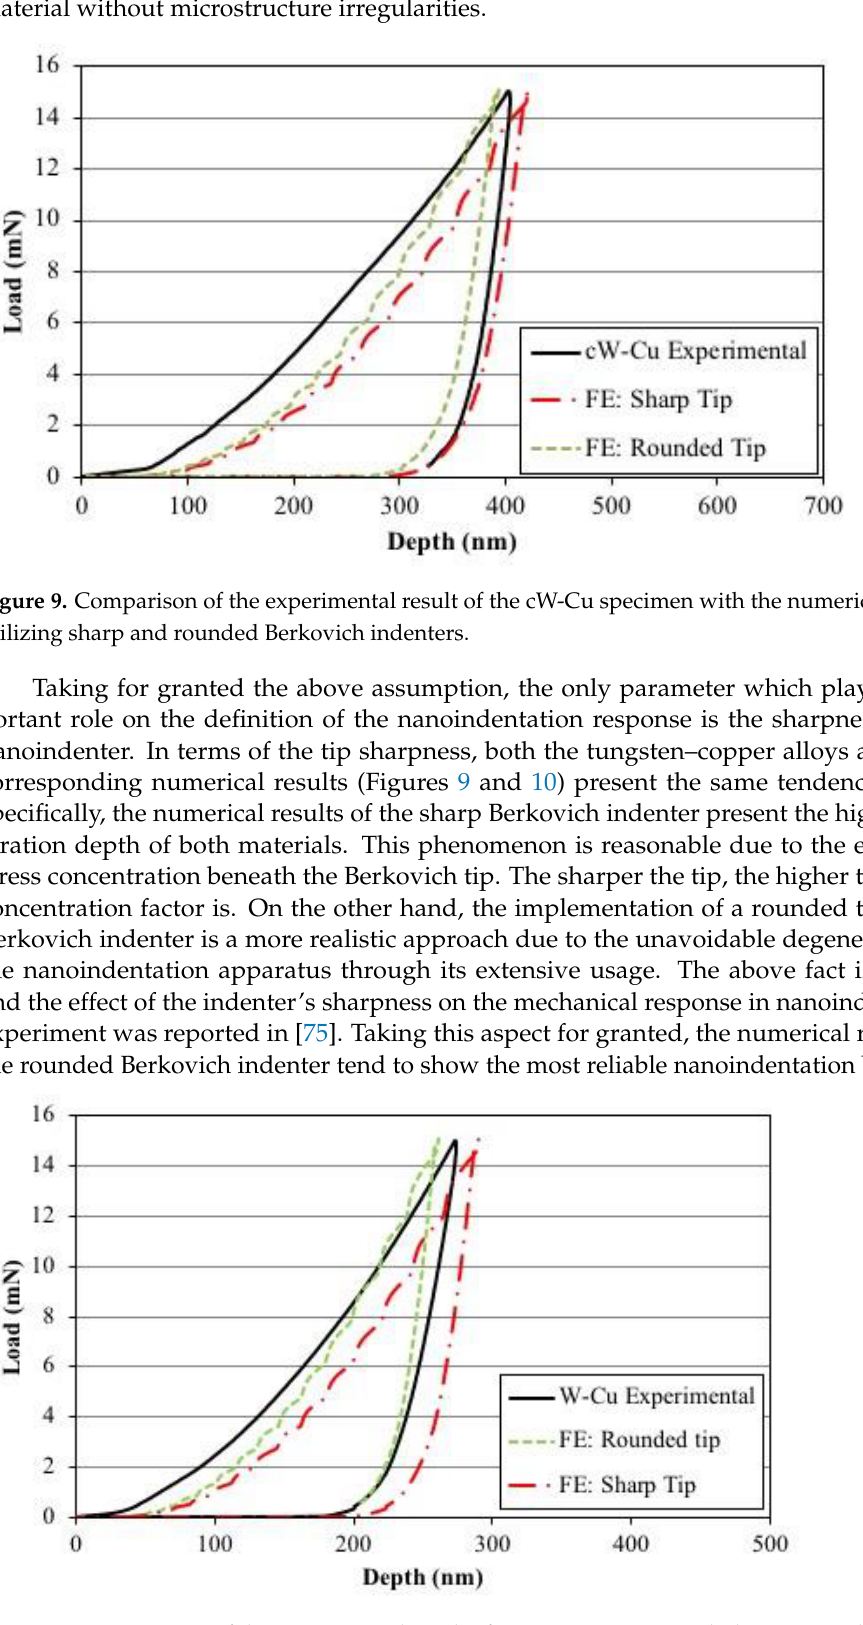
Figure 10. Comparison of the experimental result of a W-Cu specimen with the numerical results of a fully dense model utilizing sharp and rounded Berkovich indenters. To sum up, the experimental P - h curve better reflects the nanoindentation behavior of a fully dense material than of a material with an extensive porosity like the examined specimens in this paper. The proposed numerical methodology shows a very good con- vergence with the nanoindentation test. On the other hand, utilizing the inverse algorithm